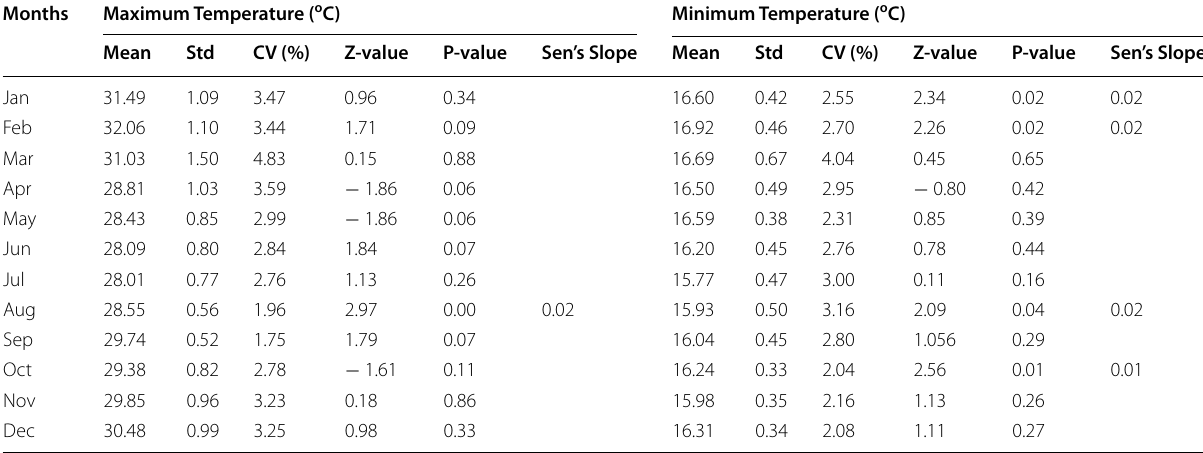
Table 2 Descriptive statistics and test results for mean Tmax and Tmin